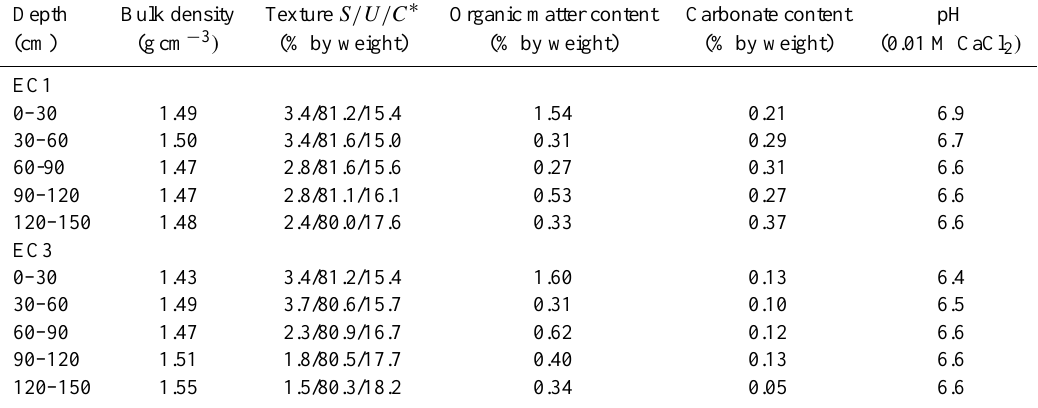
Table 1. Basic soil properties of the fields EC1 and EC3. At both sites the soil type is Stagnic Luvisol (IUSS Working Group WRB, 2007). Depth Bulk density Texture S/U/C ∗ Organic matter content Carbonate content pH (cm) (gcm − 3 ) (% by weight) (% by weight) (% by weight) (0.01 M CaCl 2 )